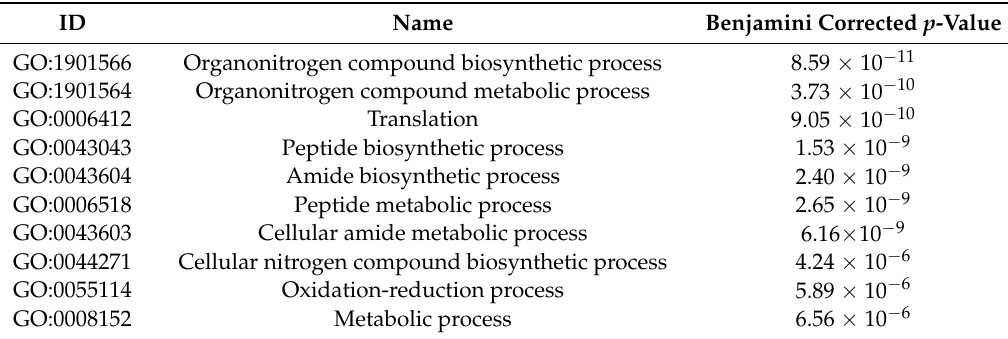
Table 1. Gene ontology enrichment analysis of the most abundantly expressed genes in C. gattii recovered from BAL. The top ten enriched Biological Process terms are shown. Only Benjamini- corrected p -values < 0.5 were considered as significantly